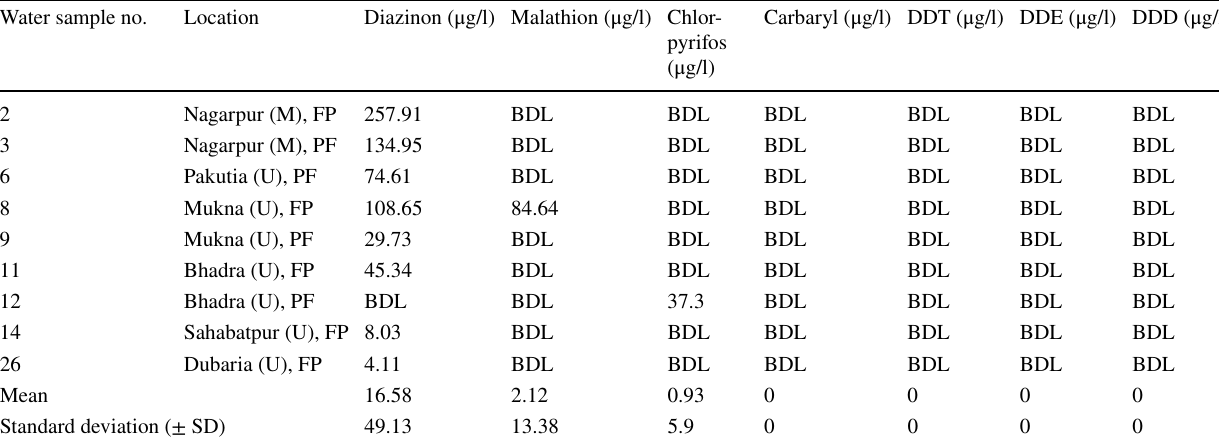
M municipality, U union, FP fish pond, PF paddy field, BDL bellow detection limit, below detection limits (BDL) which stand 0 for the calcula- tion of mean and standard deviation, total number of water sample is 40 but only location-wise contamination status has been presented